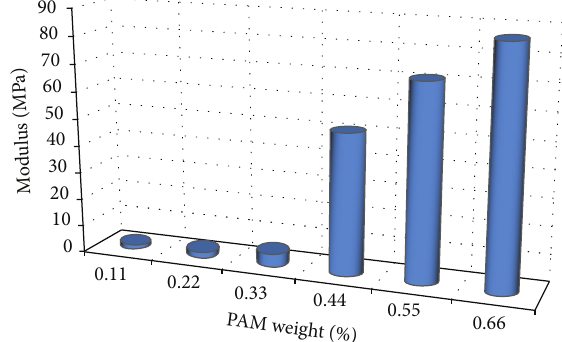
Figure 9: Modulus of elasticity of sand-polymer composites con- taining various polymer weight